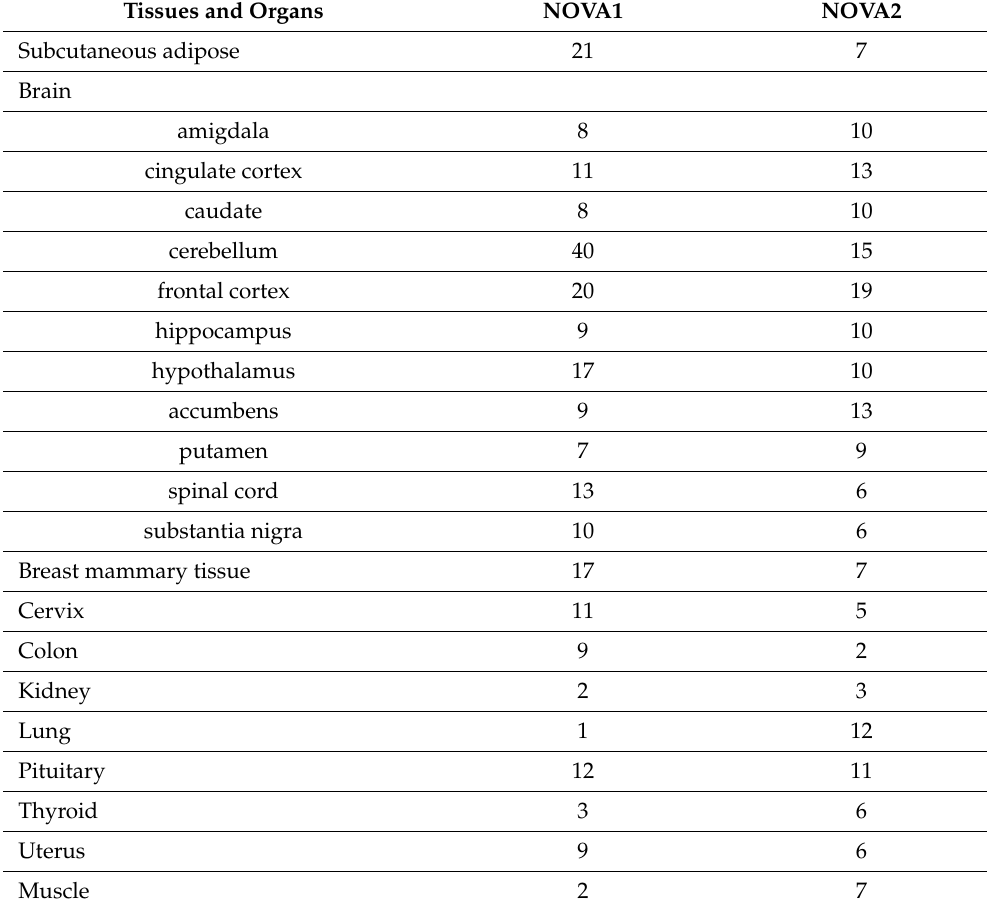
Table 1. Gene expression (TPM) of NOVA1 and NOVA 2 in human